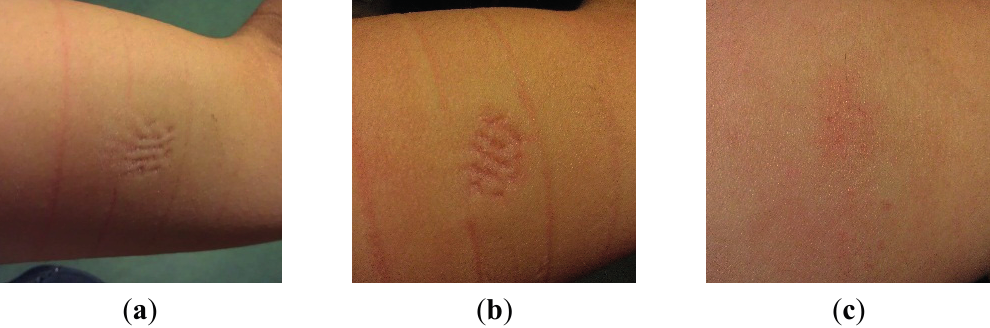
Figure 16. Skin condition ( a ) after 10 h of electrode/skin contact; ( b ) after 35 h of electrode/skin contact; ( c ) 4 h after the electrode was